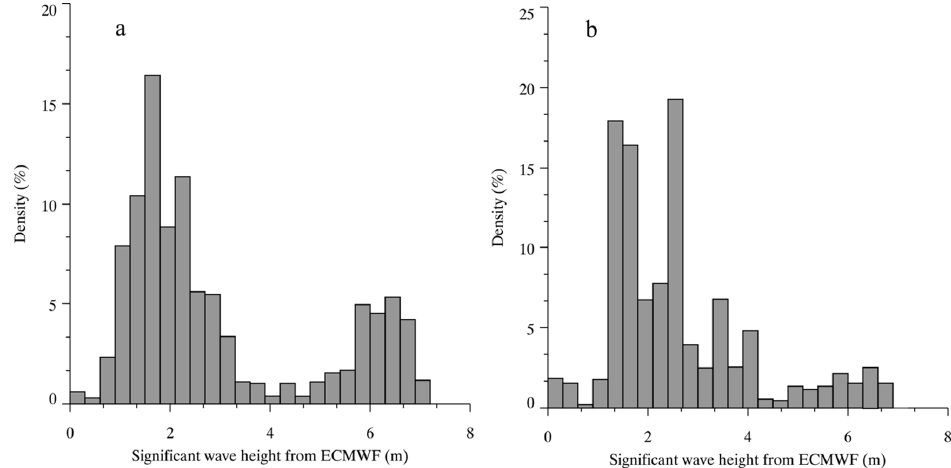
Figure 3. Histograms of SWH matchups at interval of 0.3 m. SWH ranges from 0 to 7 m: ( a ) VV- polarization; and ( b ) HH-polarization.